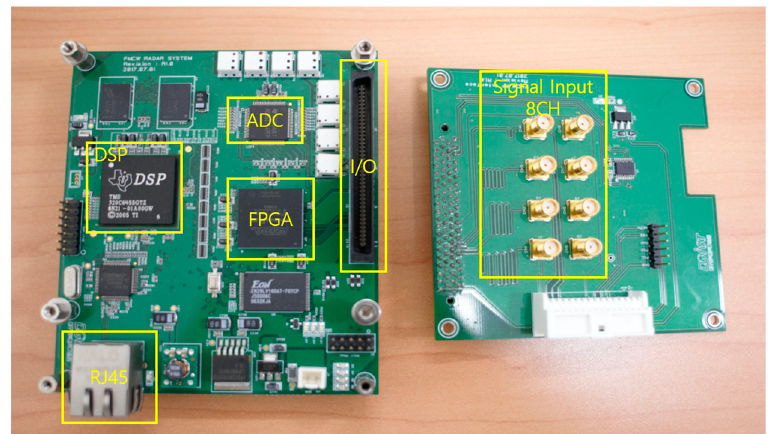
Figure 12. Photograph of the developed data-logging platform.